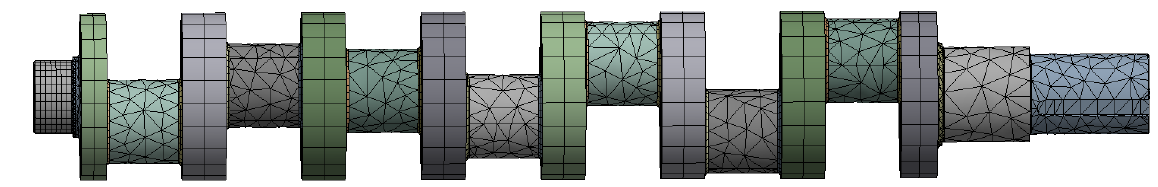
Figure 20. Diagram of the crankshaft automatic meshing.